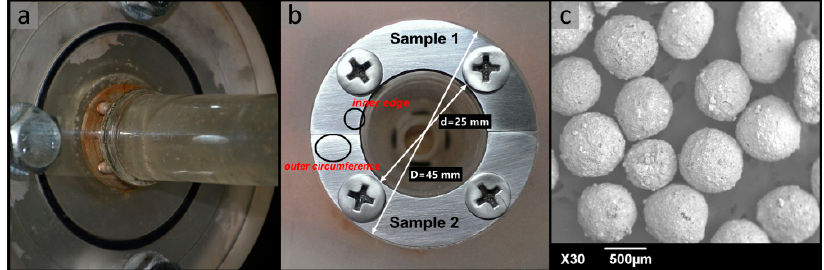
Figure 6. Physical map of the test section: ( a ) Diagram of the contraction section; ( b ) installation drawing of the samples; ( c ) particle surface morphology scanned by SEM.